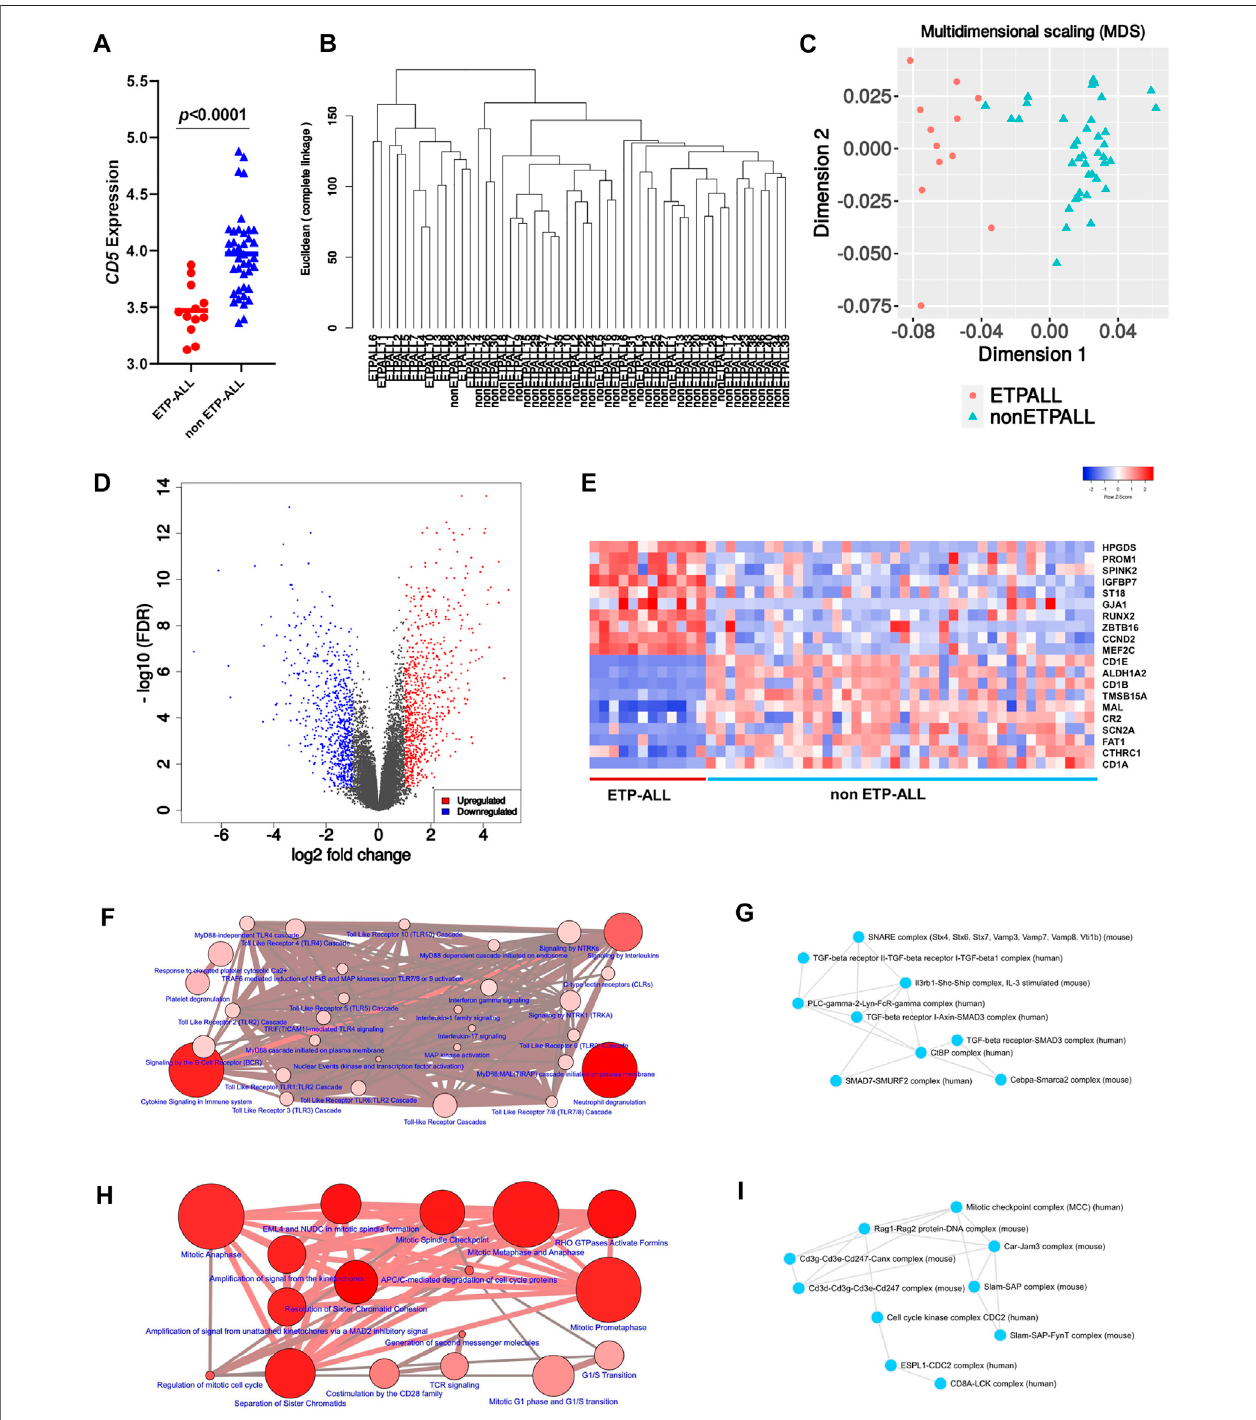
FIGURE 2 | Contrasting transcriptomic features between ETP-ALL and non-ETP-ALL. (A) Expression level of CD5 in ETP-ALL and non-ETP-ALL groups from GSE28703 dataset. Statistical signi fi cance was calculated using two-tailed unpaired Student ’ s t-test. (B) Rooted dendrogram of all samples from GSE28703 dataset showing unsupervised hierarchical clustering between ETP-ALL and non-ETP-ALL. (C) Multidimensional scaling (MDS) plot of ETP-ALL (red circle) and non-ETP-ALL (cyan triangle)samplesfrom GSE28703. (D) Volcano plot representing differentially expressed genes(fold change > 2,false discovery rate < 0.1) betweenETP-ALL and non-ETP-ALL groupsfromGSE28703.Reddotsrepresent genesupregulated,while bluedotsrepresent genesdownregulatedinETP-ALLcomparedtonon-ETP- ALL. (E) Row z-score normalized unclustered heatmap of expression levels of top 20 differentially expressed genes between ETP-ALL and non-ETP-ALL groups from GSE28703. (F) Network ofREACTOME pathwaysenrichedingenesupregulated inETP-ALL.Diameterand colourintensity ofnodes represent geneset sizeand statistical con fi dence, respectively. (G) Network of protein complexes from CORUM enriched in genes upregulated in ETP-ALL. (H) Network of REACTOME pathways enriched in genes downregulated in ETP-ALL (upregulated in non-ETP-ALL). (I) Network of protein complexes from CORUM enriched in genes downregulated in ETP-ALL.